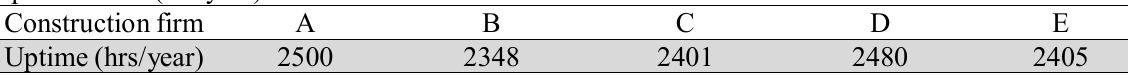
Construction firm